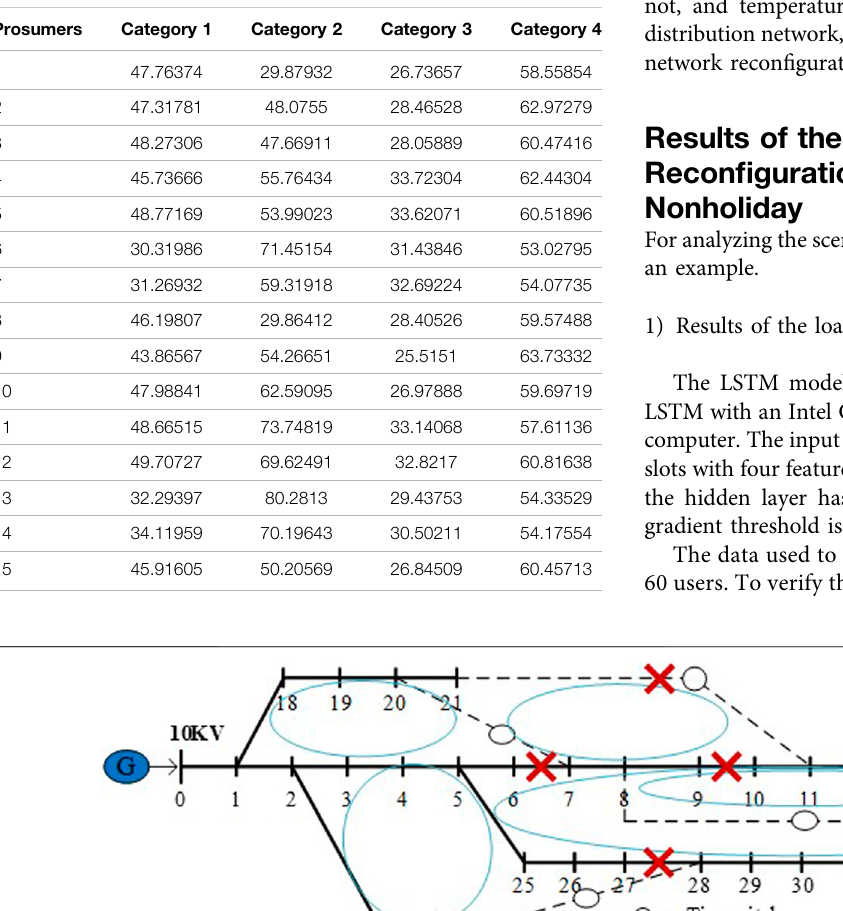
TABLE 1 | Predicted load of partly prosumers.